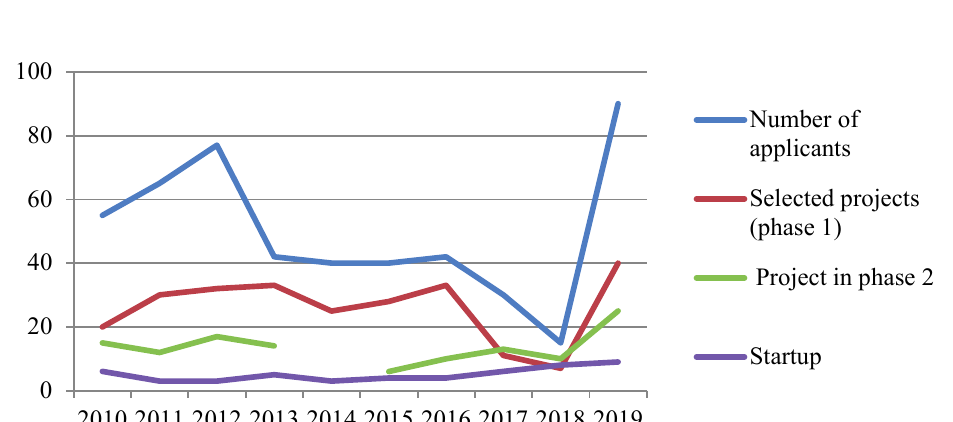
Fig. 5. History of the activity (the author’s contributions based on the documentation provided by NATP, 2020).